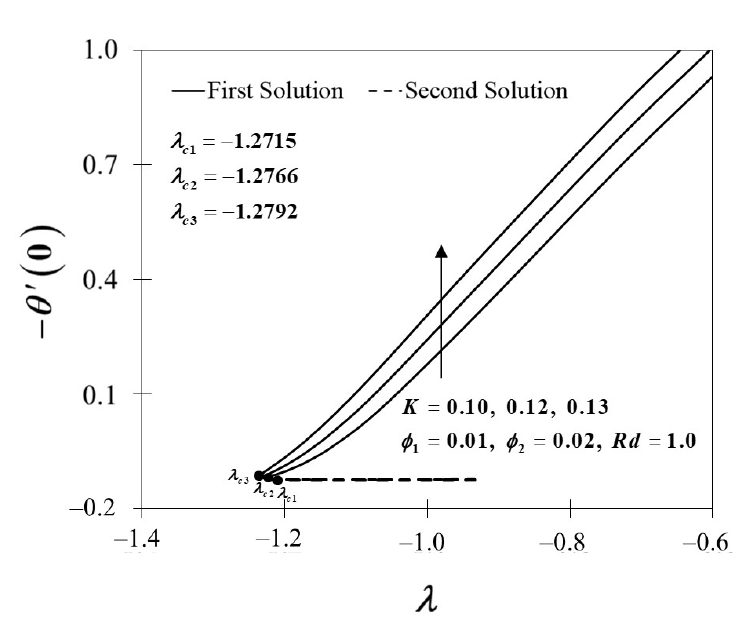
Figure 9. − θ (cid:48) ( 0 ) towards λ by assorted K .